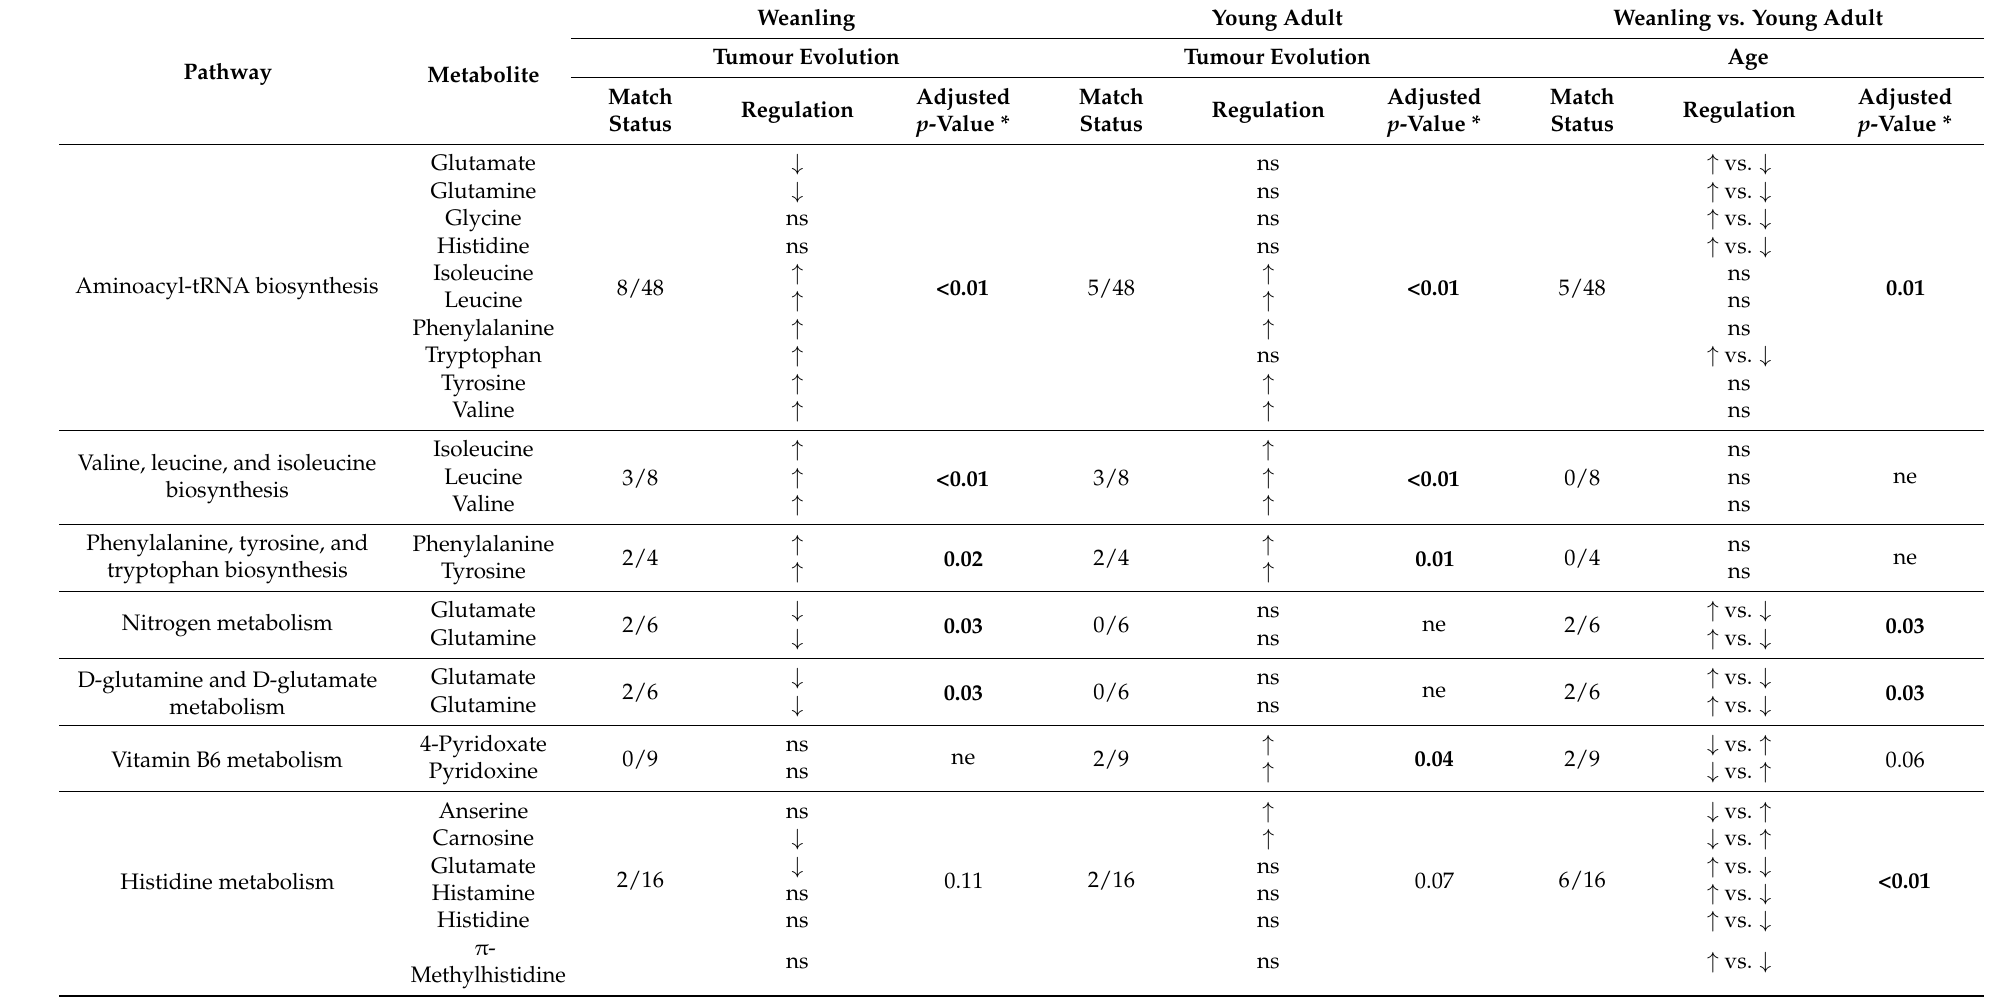
Table 1. Metabolic pathways identified in weanling and young adult female Walker-256 tumour-bearing